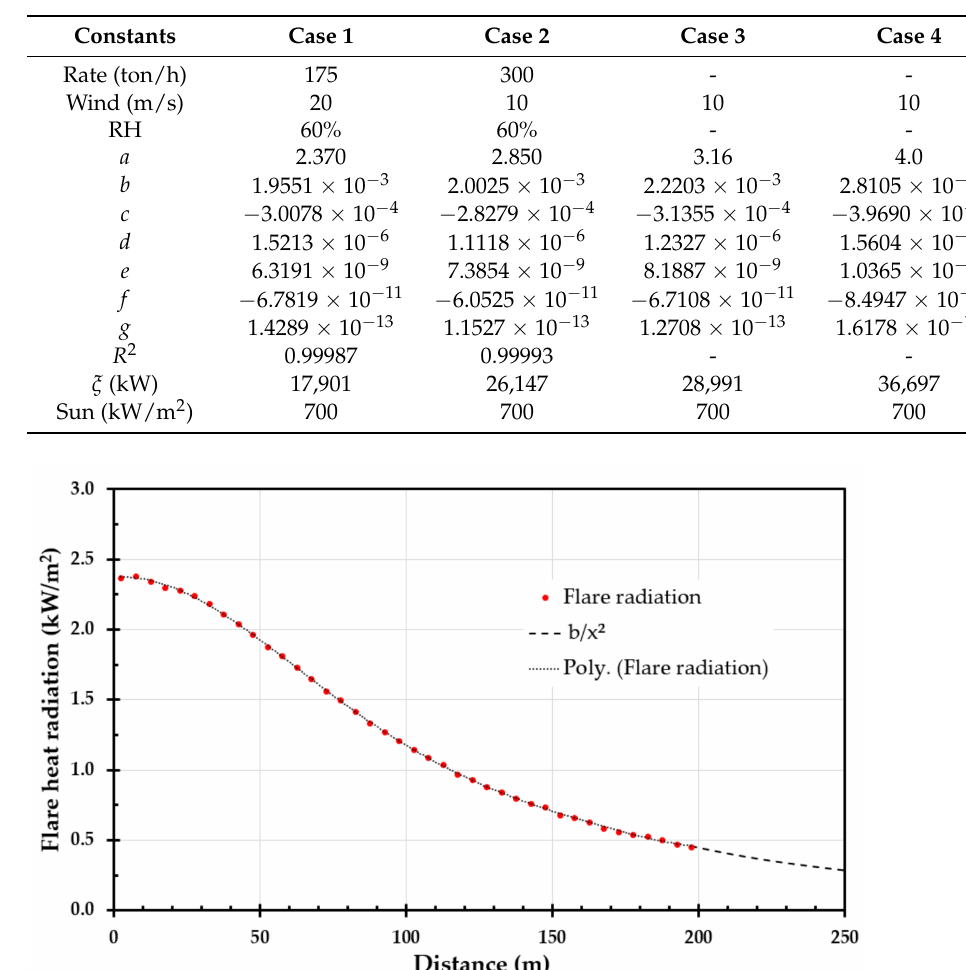
Table 2. Flare rate, wind speed, relative humidity for the heat radiation modeling, as well as the constants of Equation (14) and the corresponding regression coefficient (squared). The constant of Equation (15) is also given for the selected cases.